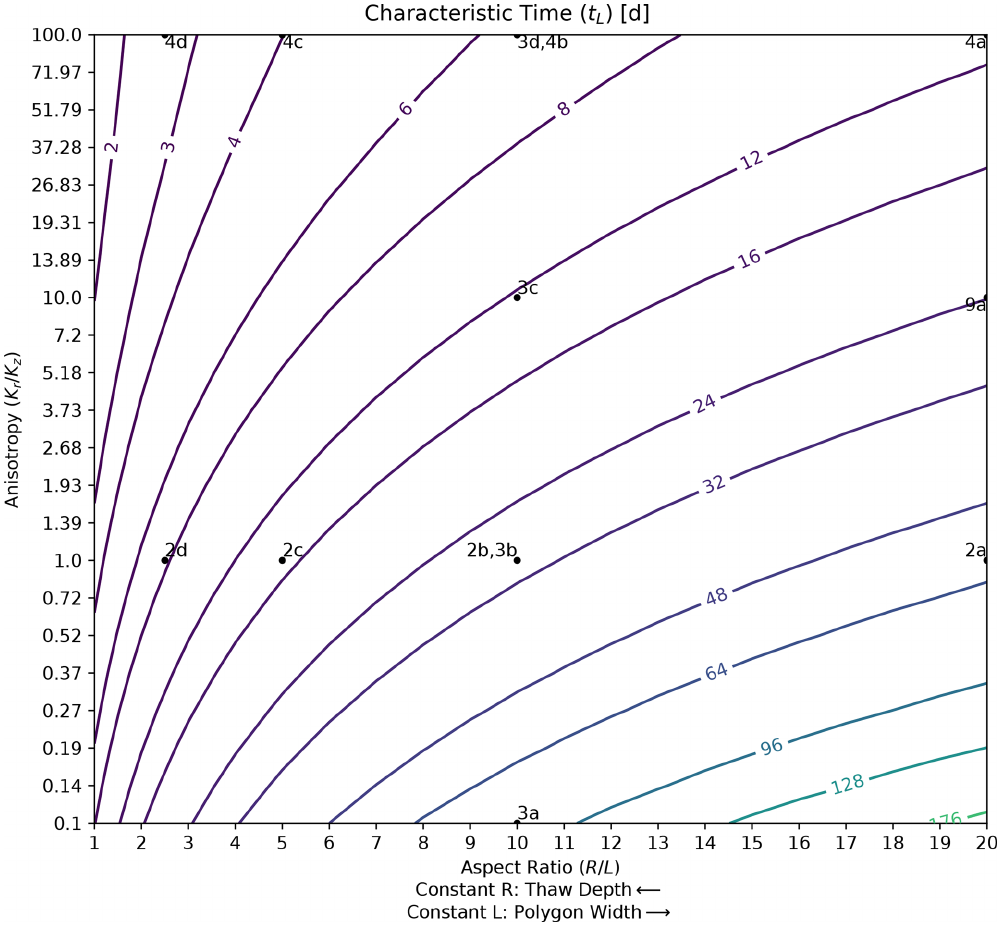
Figure 10. Contour map of the characteristic time of polygon drainage as a function of polygon aspect ratio and anisotropy coefficient. Locations associated with other figures are indicated by labeled points. By choosing a constant value for R ( L = R/x ), horizontal transects parallel to the x axis represent the effect of thaw depth increasing from right to left, while they represent increasing polygon width from left to right for constant values of L ( R = Lx ). Note that κ = 5d − 1 in these calculations, and therefore, the location associated with Fig. 11b cannot be